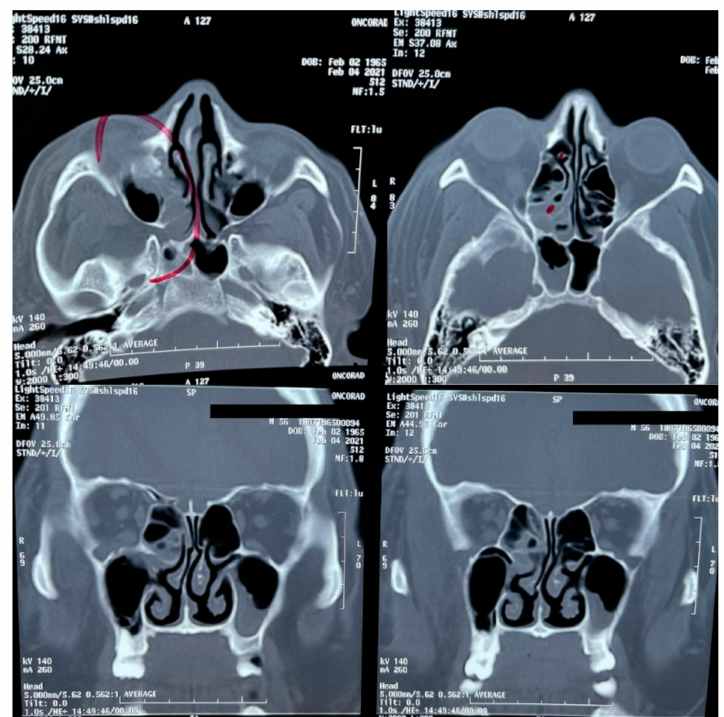
Figure 4. CT-scan of the paranasal sinuses.